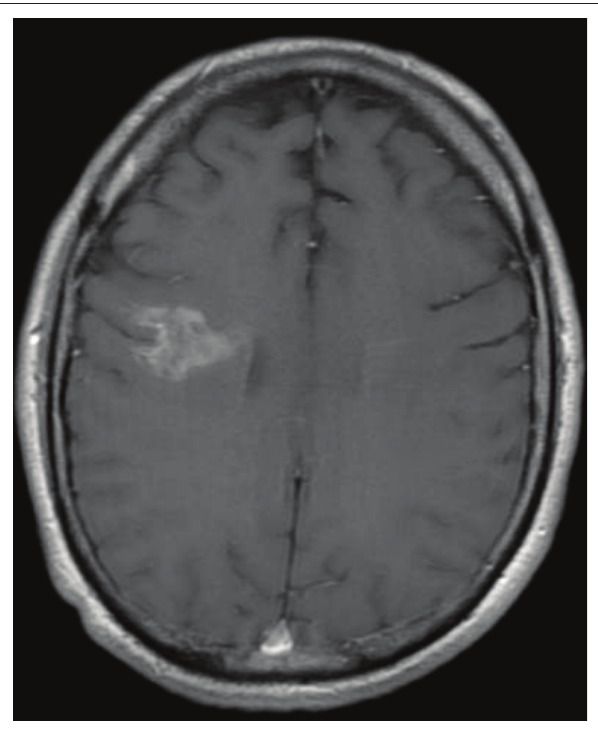
FIGURE 5: Axial post-contrast T1-weighted MR image.